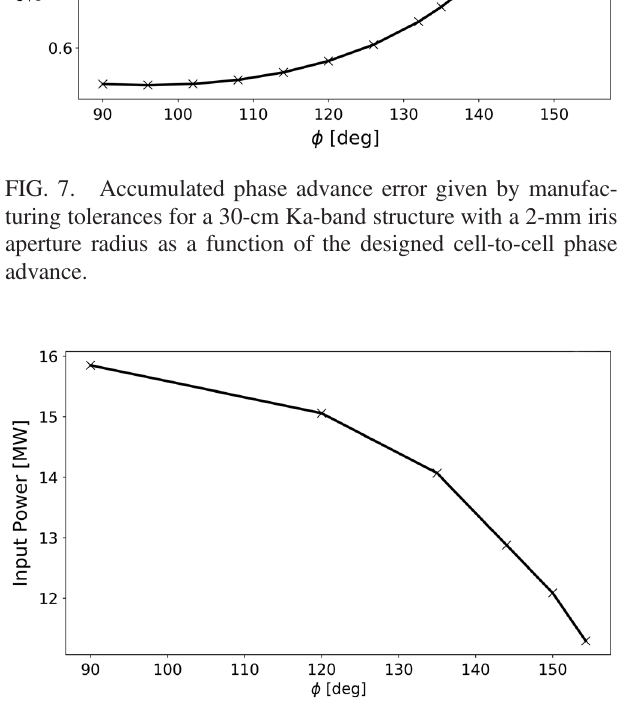
FIG. 8. Power requirement for a 30-cm, 36-GHz structure, to provide 12.75-MV integrated voltage, for different phase advances.